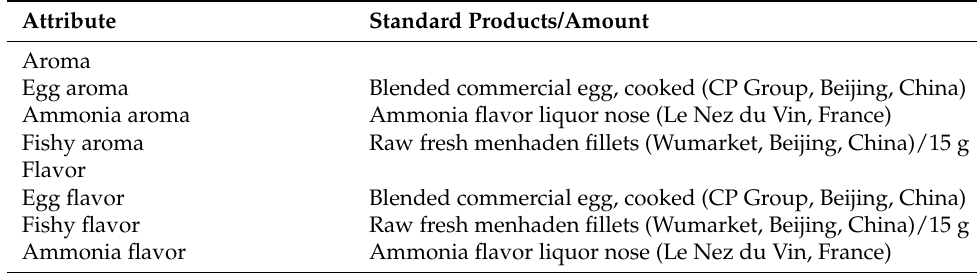
Table 1. Aroma, flavor, and texture standard products used as reference in training